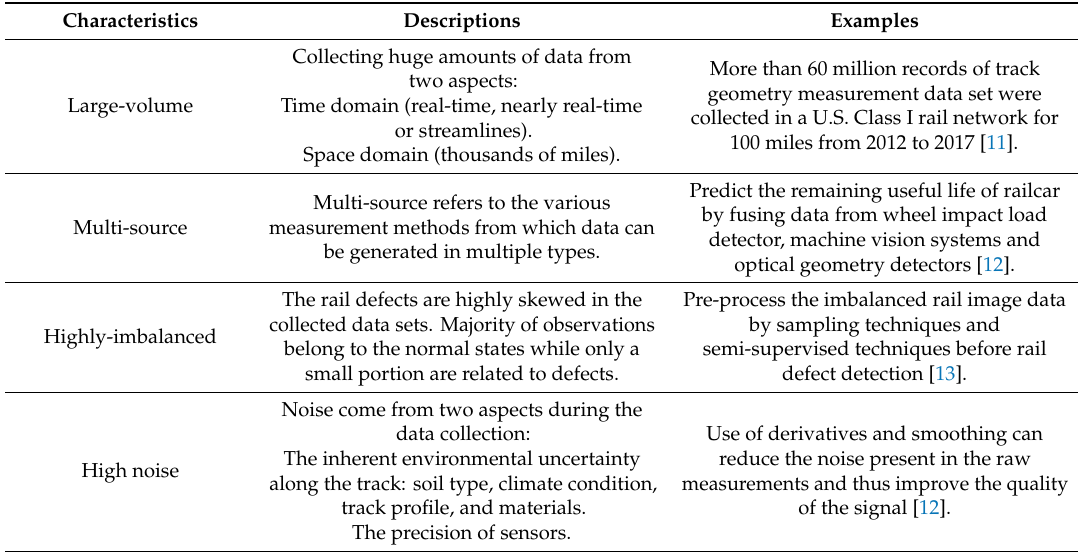
Table 1. Characteristics of railway measurement